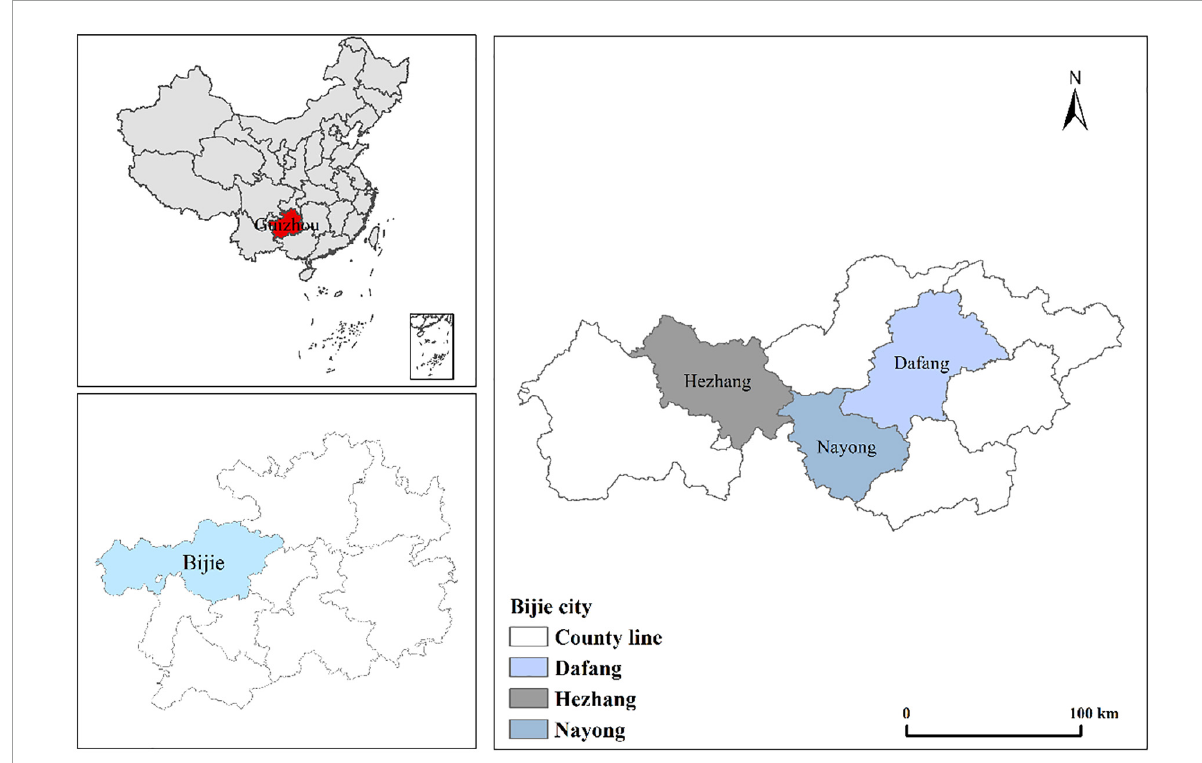
FIGURE1 The map of the study area showing wheat grain sampling sites in Bijie, Guizhou